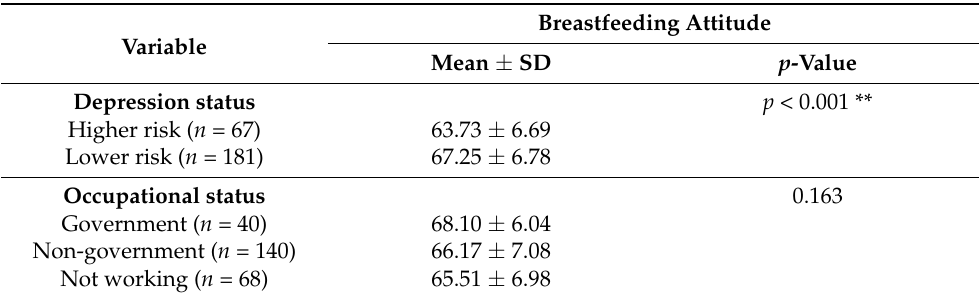
Table 4. Mean score of breastfeeding attitude and its associated factors among mothers with prema- ture infants in Neonatal Intensive Care Units (NICUs) ( n = 248).